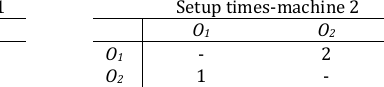
Processing times